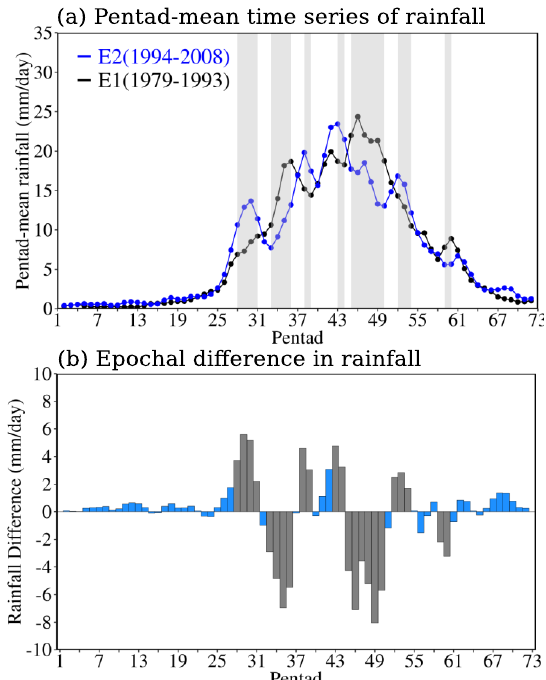
Figure 3. ( a ) Smoothed (1–2–1 filter) pentad-mean rainfall between E1 (1979–1993) and E2 (1994–2008) averaged across the seven PAGASA stations on the western coast of the Philippines; and ( b ) their epochal difference. Shaded pentads in ( a ) and grey bars in ( b ) indicate statistically significant difference above the 95% confidence level using the t -test.